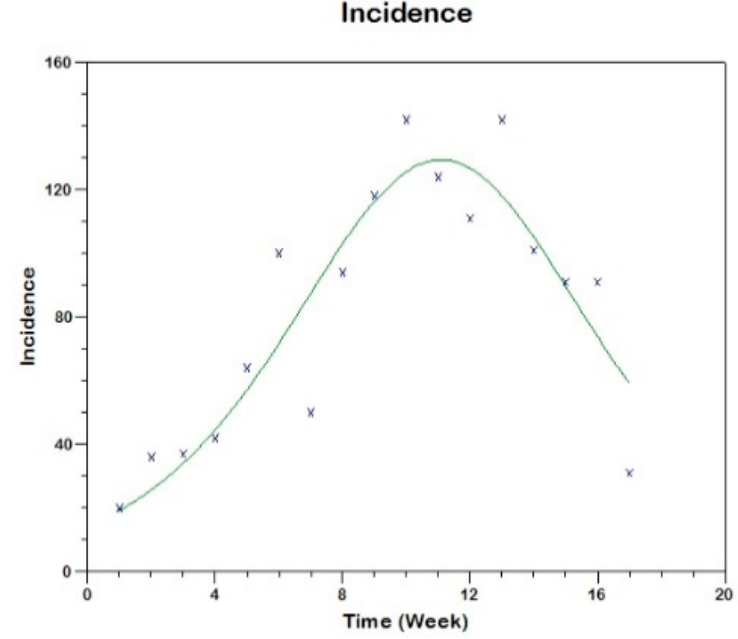
Figure 14. Model fit to the cumulative reported incidence of the second outbreak in Tolima-Colombia using Method 1. Trop. Med. Infect. Dis. 2018 , 2 ,